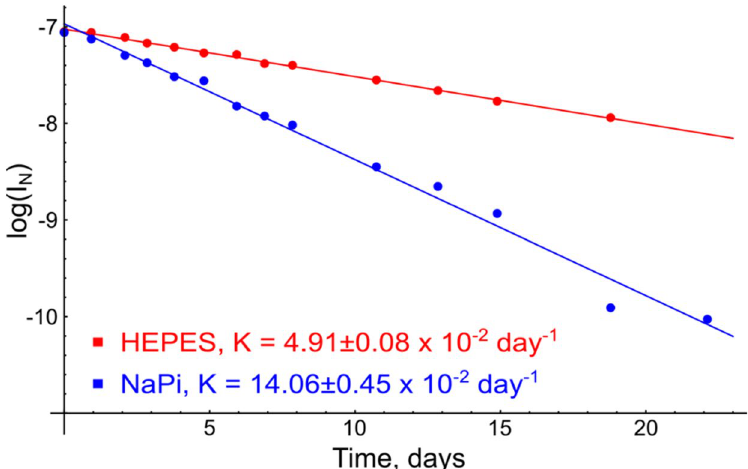
Figure 3. The kinetics of hP75DD deamidation in phosphate and HEPES buffers. The intensity of signal, corresponding to the N352 form of hP75DD is plotted as a function of time in a logarithmic scale. Two experiments are shown: in 20 mM HEPES pH 7.0 (in red) and 50 mM NaPi, pH 7.0 (in blue). The Figure was prepared using the program Inkscape 0.92 (https ://inksc